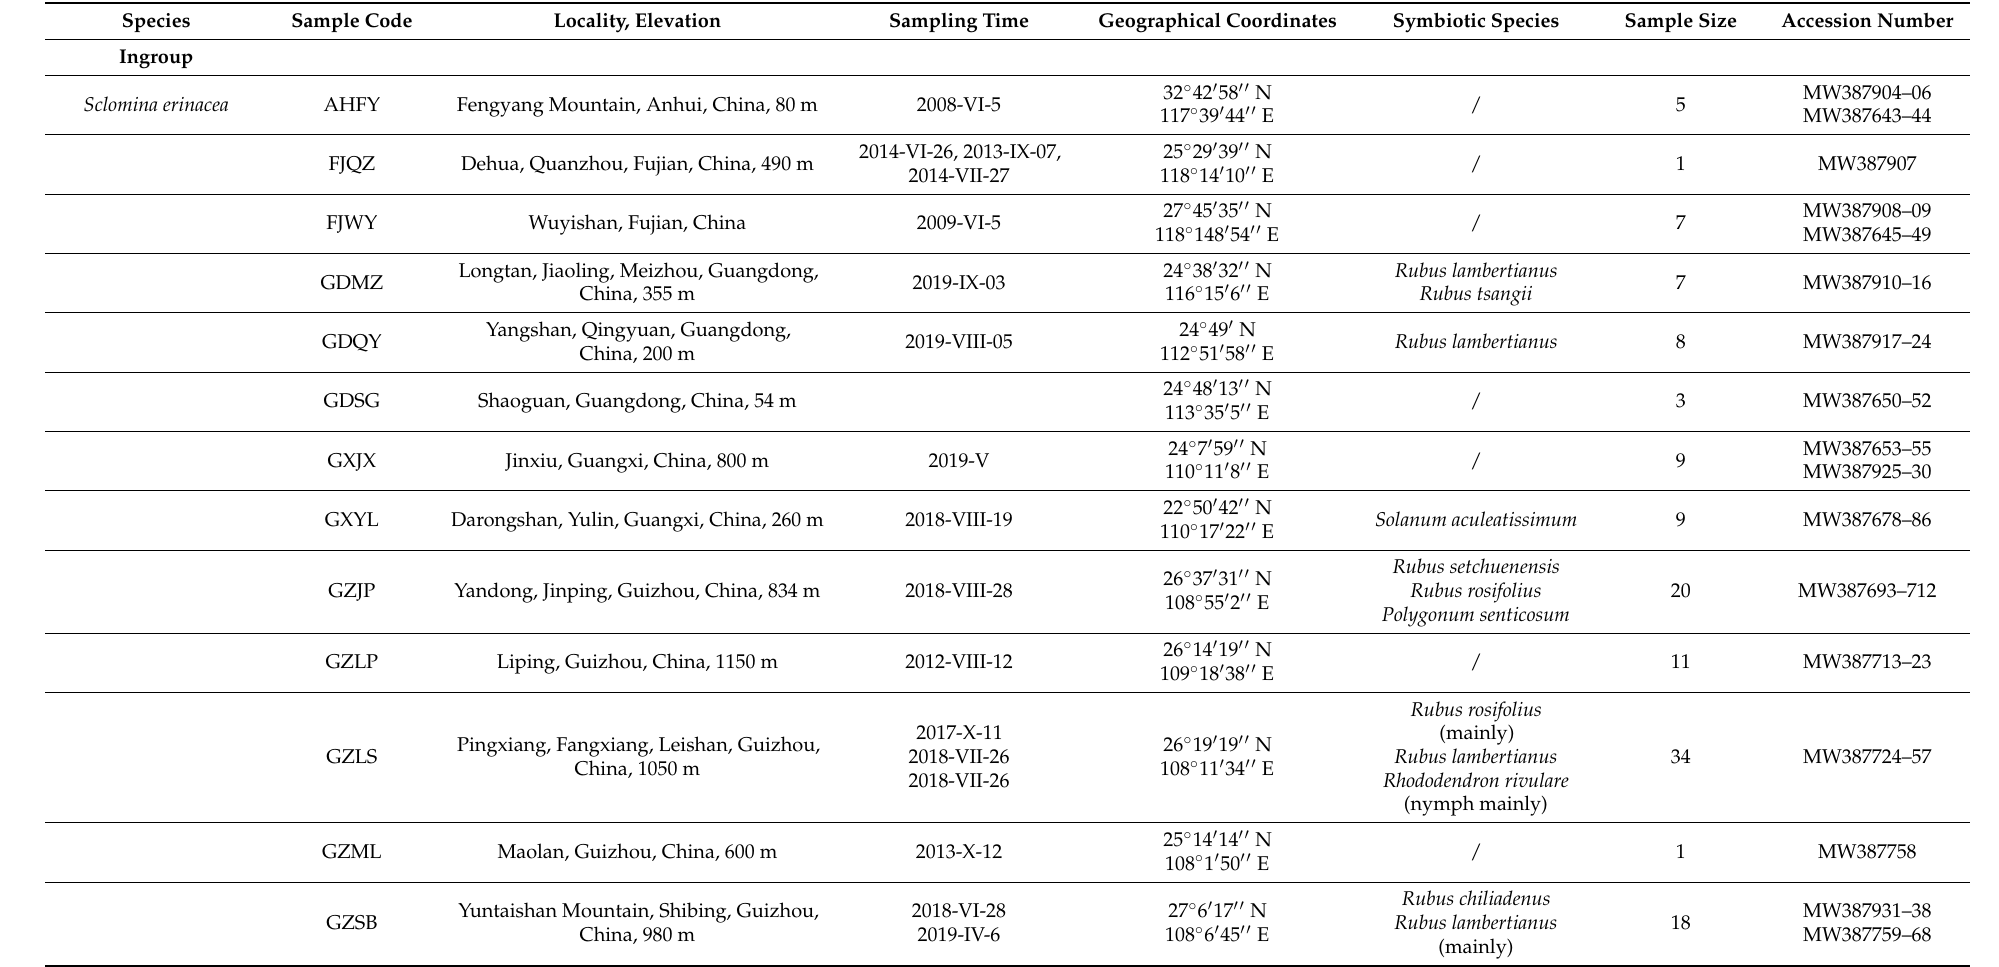
Table A1. Information on the samples used in the molecular study and GenBank Accession